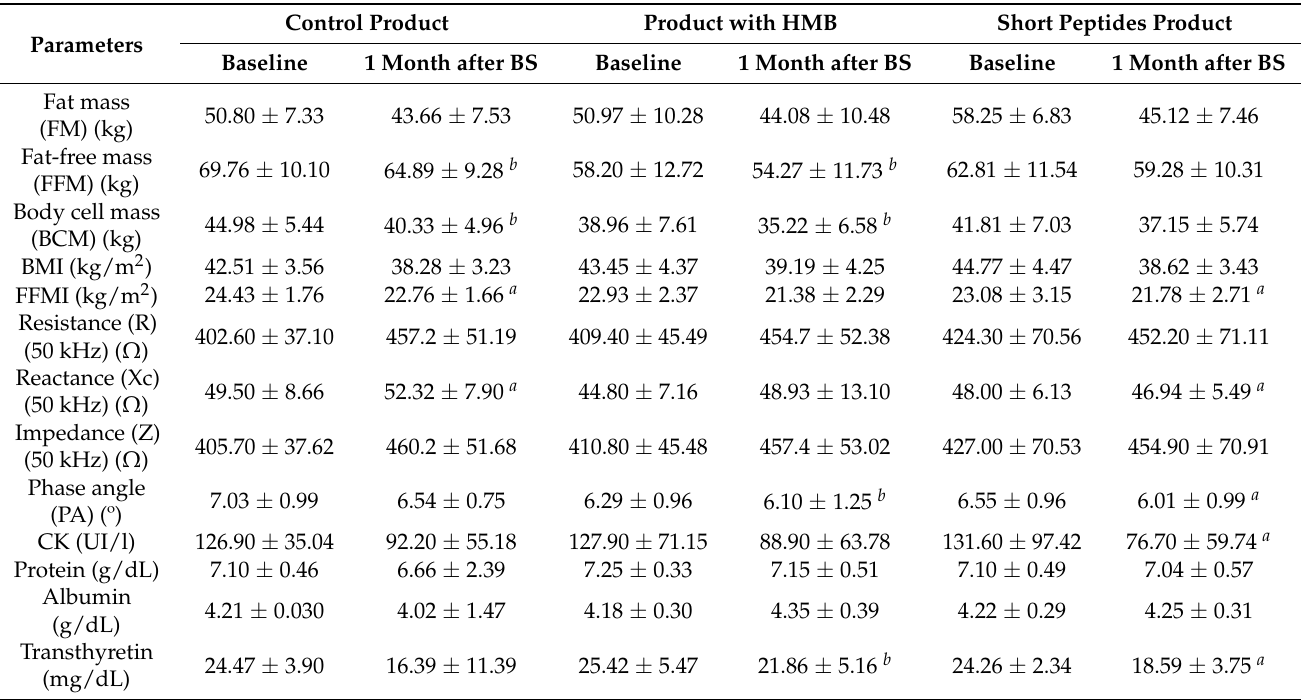
Table 3. Body composition evolution before and 1 month after bariatric surgery according to nutri- tional